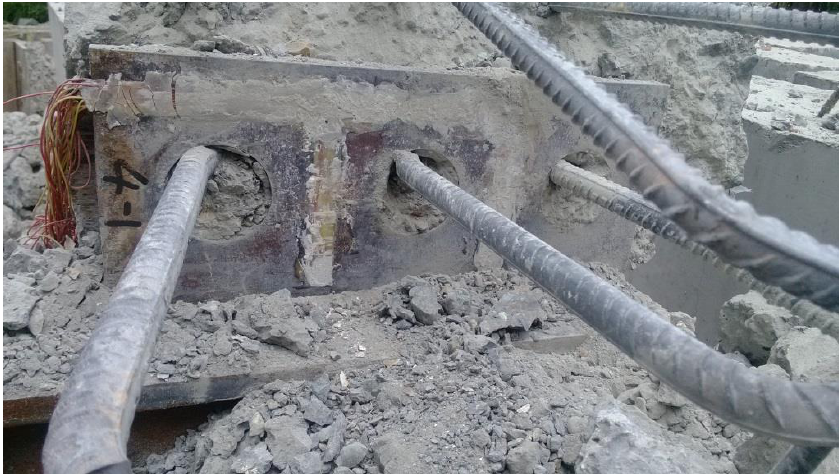
Figure 12. Concrete dowel, rib plate, and reinforcement of the BH 4-1 specimen after the test.